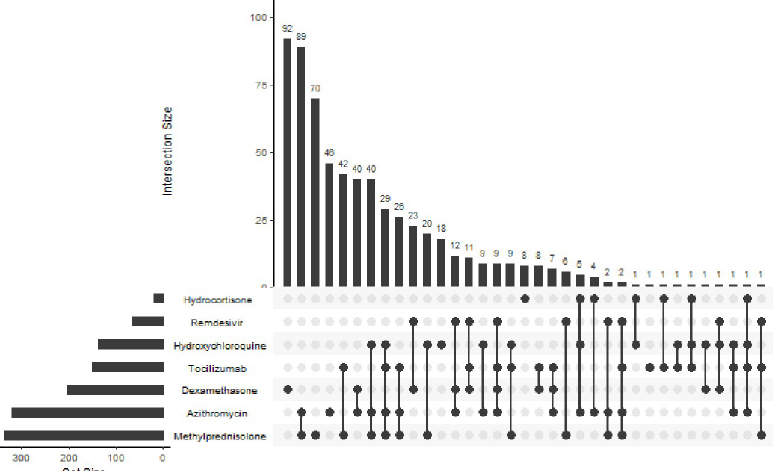
Fig 1. Combinations of drugs used in management of COVID-19. In this Upset graph, each row represents a drug. Each column represents a combination of drugs. A filled dot indicates that drug is included in the column